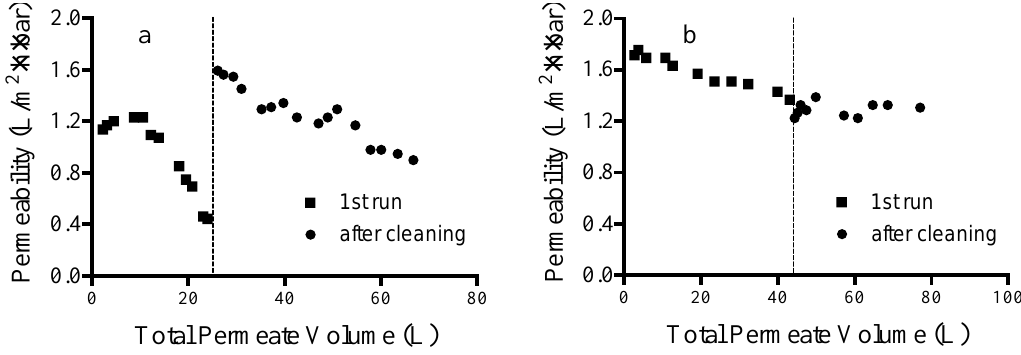
Figure 4. ( a ) Cross-flow filtration results for MPF-34 NF membrane. Each run was done for a period of 96 h. The vertical dashed line indicates the point where CIP was done with NaOH solution. ( b ) Cross-flow filtration results for 70UB RO membrane. Each run was done for a period of 96 h. The vertical dashed line indicates the point where CIP was done with SDS solution.